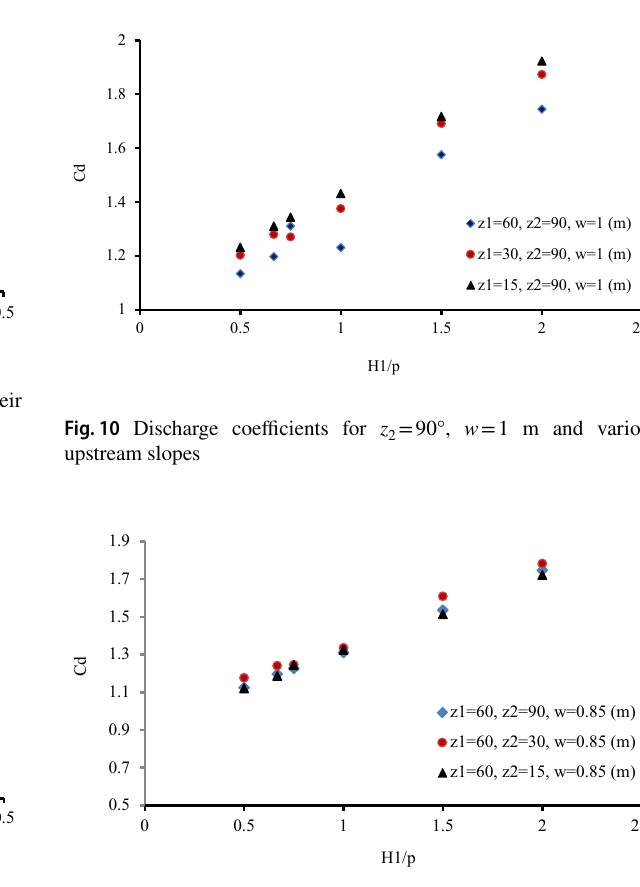
z 1 = 15°, 2 = 90° and various weir